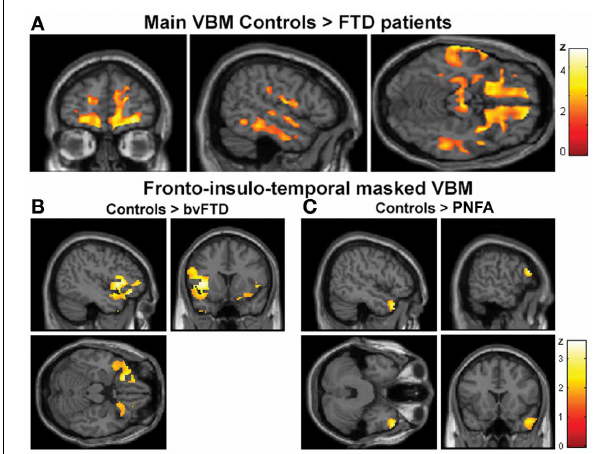
FIGURE 2 | (A) Main VBM results, atrophy of all FTD patients compared to controls, p < 0 . 05, α = 0 . 2 FDR corrected. (B) Atrophy of bvFTD group compared to controls in the frontal, insular, and temporal regions, p < 0 . 05, small volume corrected. (C) Atrophy of PNFA group compared to controls in the frontal, insular, and temporal regions, p < 0 . 05, small volume